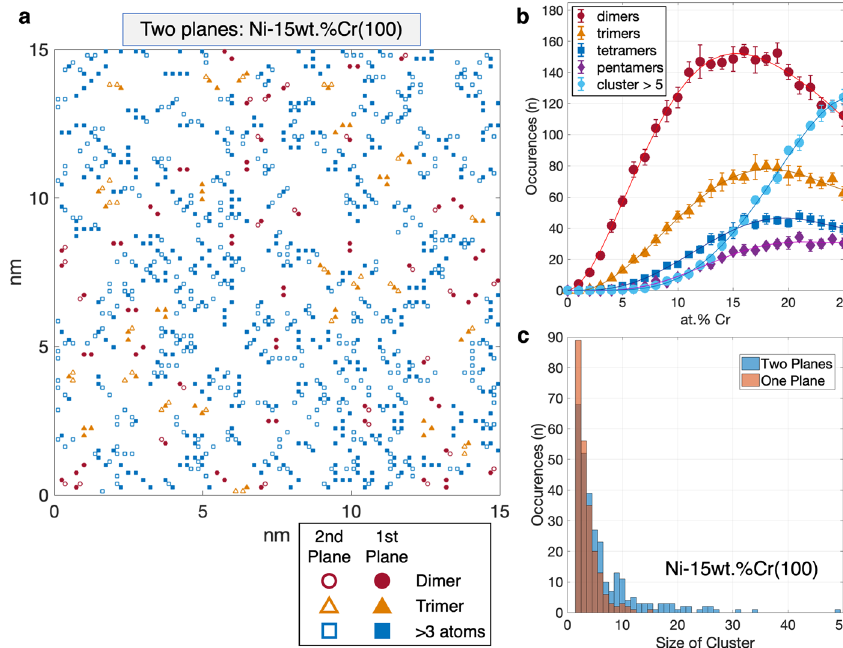
Fig. 3 Distributions of Cr atoms and clusters on the (100) surface of a random solid solution. a The visualization shows two Ni – 15 wt%Cr planes of the alloy with dimers marked with red circles, trimers orange triangles, and tetramers or larger clusters with blue squares; a closed circle/triangle/square is chosen for atoms in the fi rst plane, and an open circle/triangle/square marks atoms in the second plane. At least one atom for each cluster is positioned in the top layer ( fi rst plane), and single Cr atoms are omitted for clarity. The details of the calculation and cluster counting are described in the Supplementary Information. b Summarizes the occurrence of different cluster sizes as a function of Cr concentration in the top two (100) planes which are built of 100 × 100 atoms each. The histogram in ( c ) displays the size distribution of Cr clusters on the surface of the Ni – 15 wt%Cr alloy if a single or two planes are taken into account. The error bars in ( b ) represent the standard deviation of the data